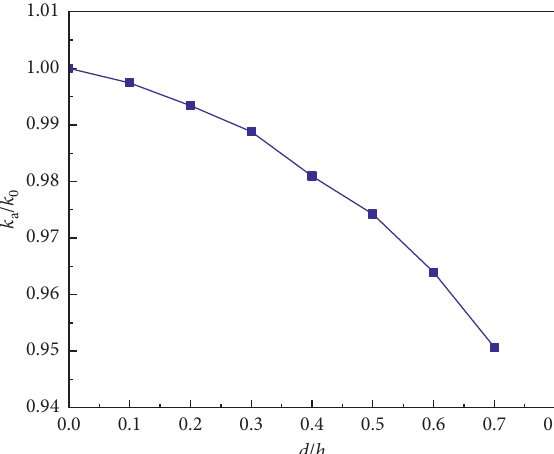
Figure 18: Distortional buckling coefficients of lipped channel columns with a circular